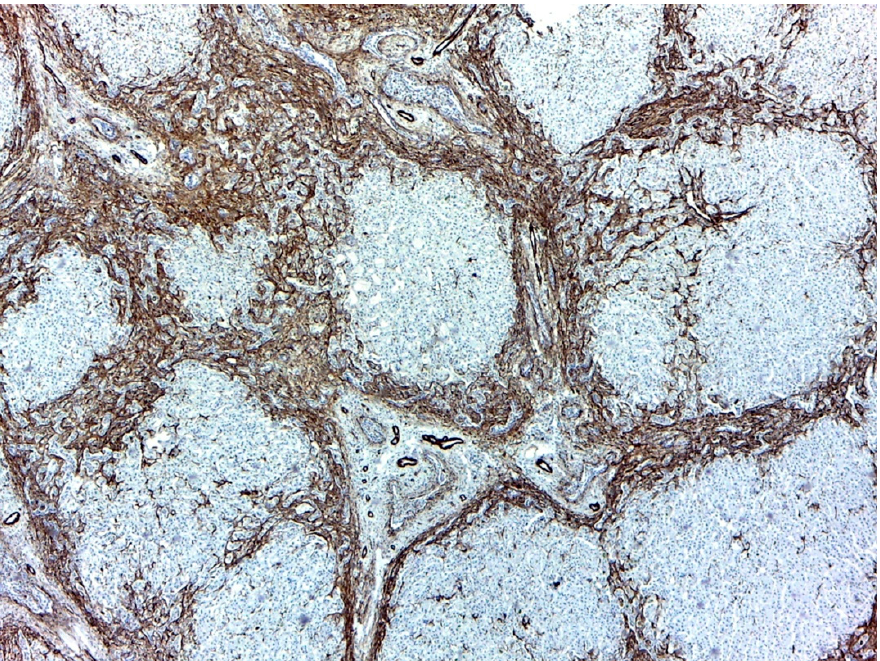
Figure 2. Smooth muscle actin (SMA) highly positive on the bridges around the neoformed bile ducts. Overall appearance 40×.